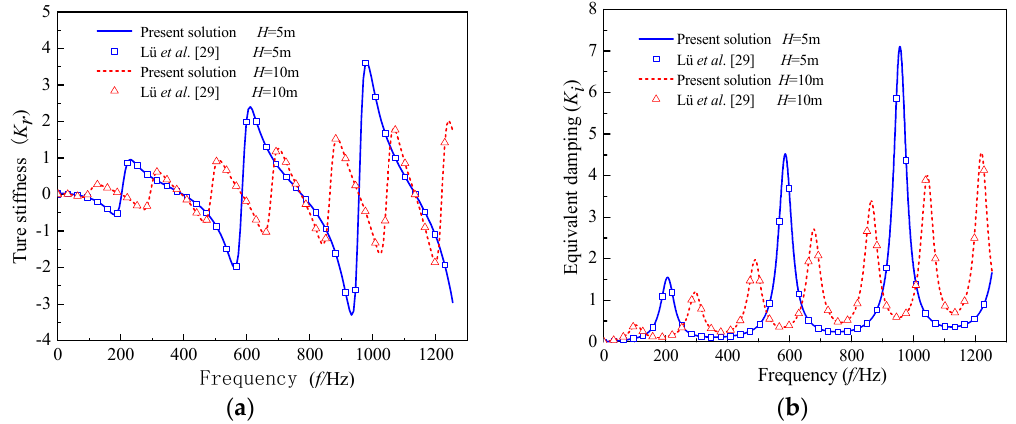
s →ζ ) and the solution of Lü et al. [29]: ( a )